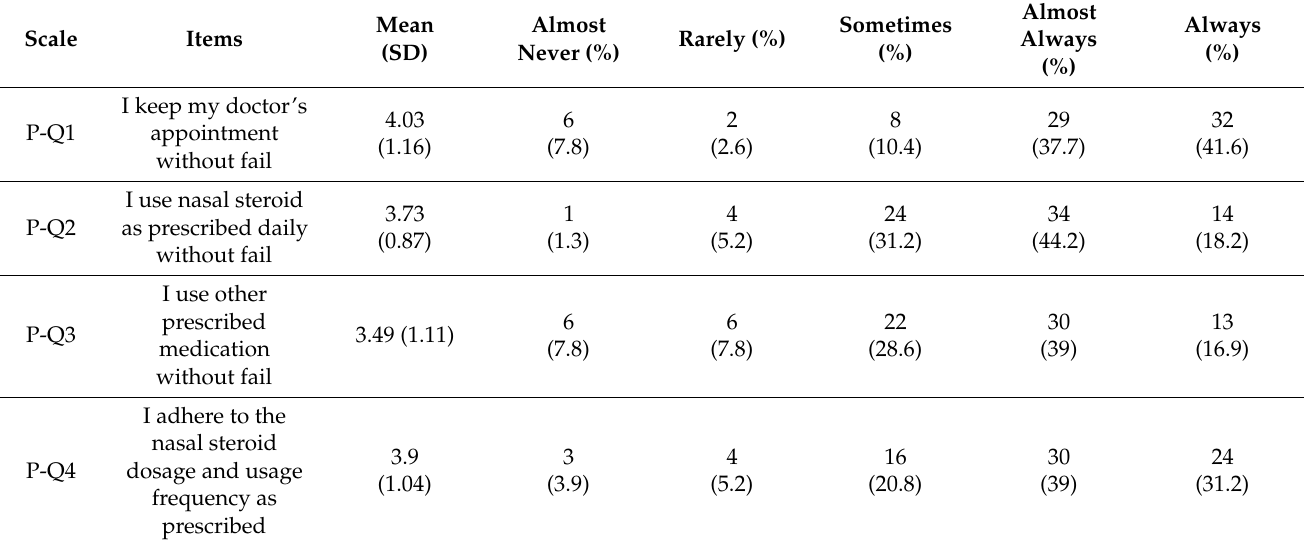
Table 5. Descriptive statistics of the items in the practice